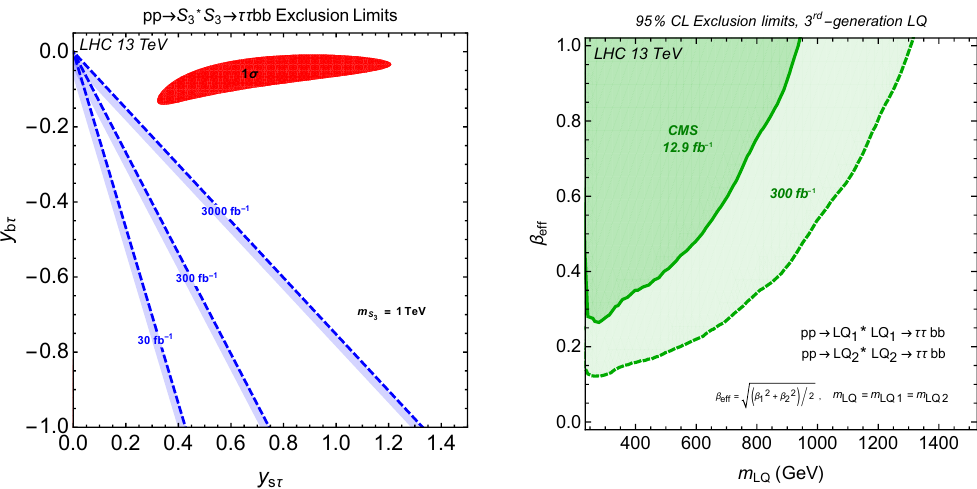
Figure 4 . (Left panel) 95% C.L. exclusion limits from LQ pair production (dotted blue lines) at di(cid:11)erent projected LHC luminosities for a 1 TeV S 3 LQ. The red region corresponds to the 1 (cid:27) low energy (cid:12)t. (Right panel) Reinterpretation of the CMS Collaboration exclusion limits for two generic degenerate LQs decaying into (cid:28)(cid:28)bb (cid:12)nal state in the (cid:12) e(cid:11) { m LQ